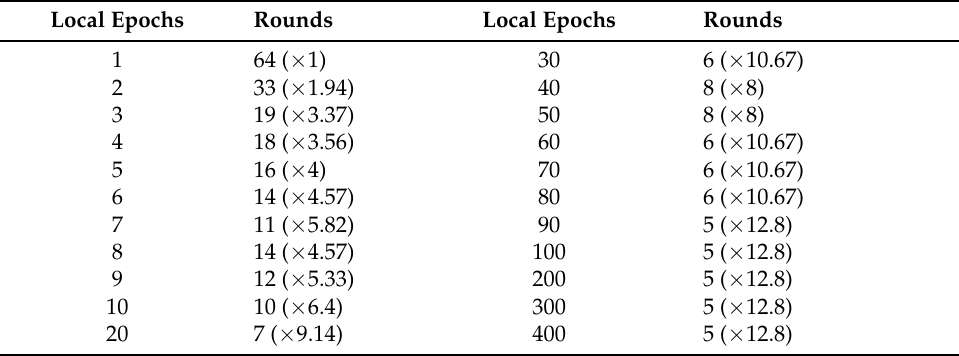
Table 3. Rounds starting to exceed 95% accuracy by local epochs (16 clients).